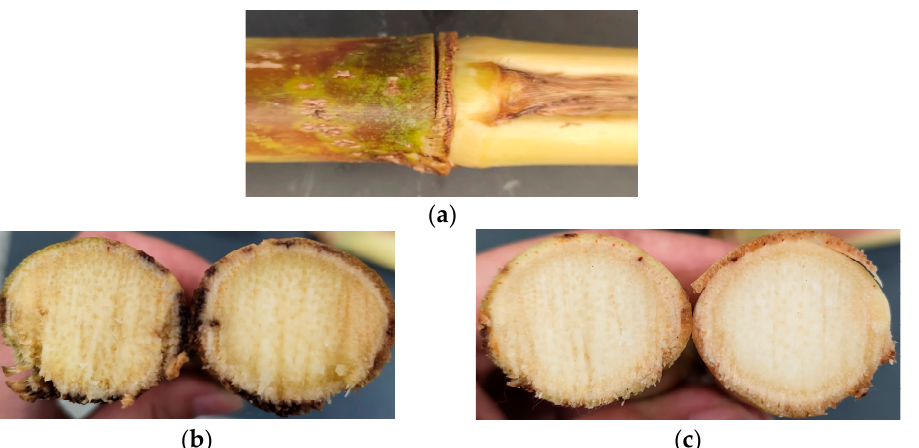
Figure 10. E ff ects of water jet cu tt ing on the stem nodes under di ff erent pressures. ( a ) 120 MPa; ( b ) Figure 10. Effects of water jet cutting on the stem nodes under different pressures. ( a ) 120 MPa; 160 MPa; ( c ) 180 MPa. ( b ) 160 MPa; ( c ) 200 MPa.